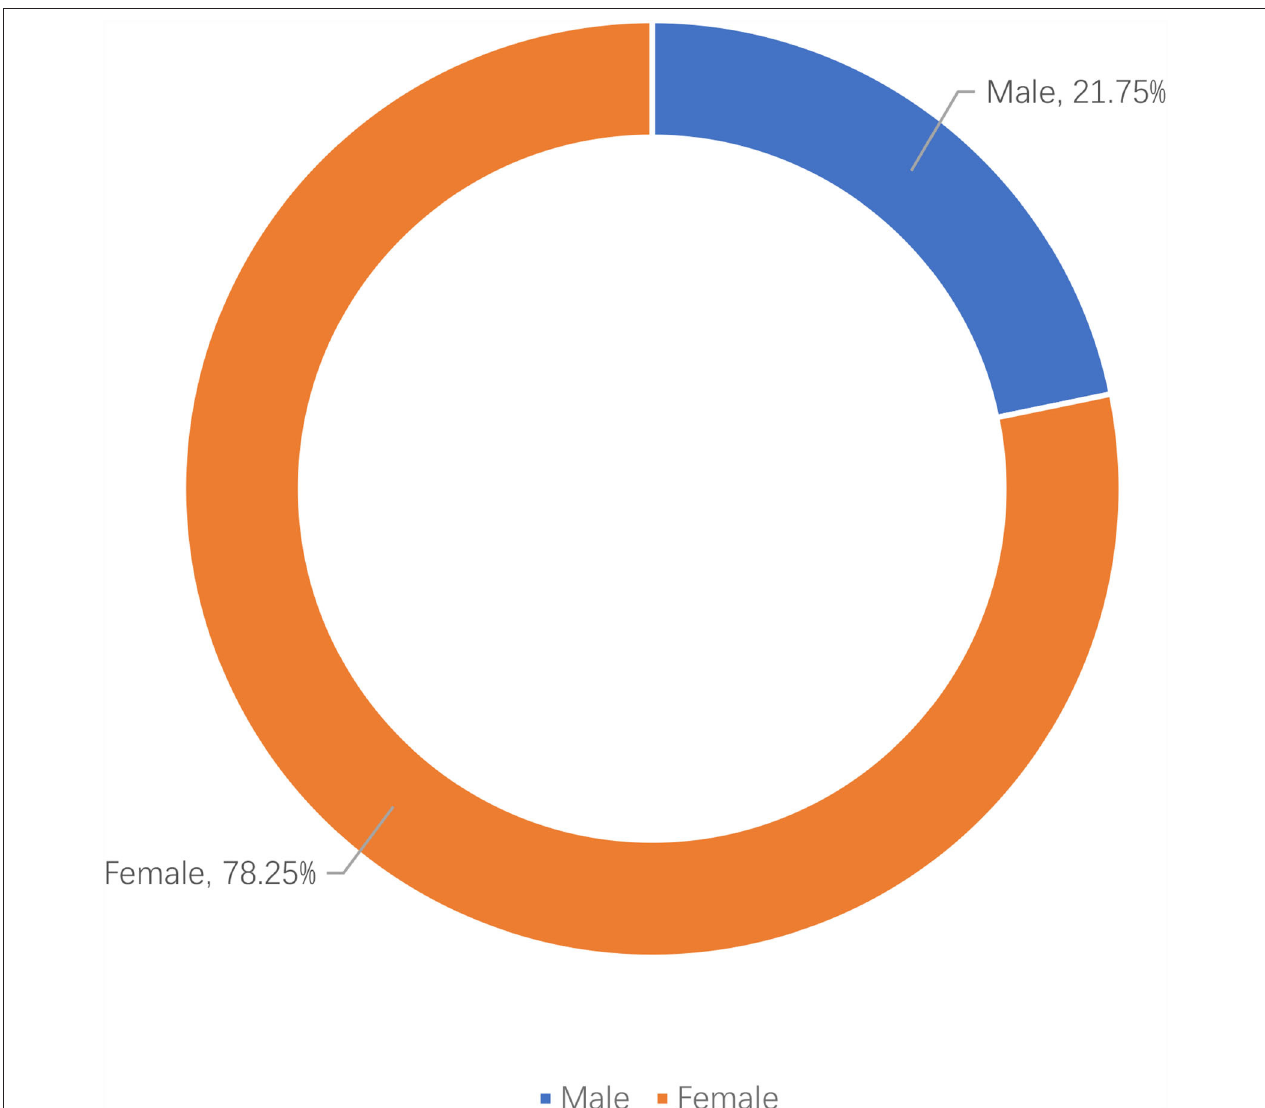
FIGURE 5 | Gender distribution of the hashtag “#national mask campaign#” participants. “advocacy from fandom community in the name of celebrity idol” is more influential, or equally